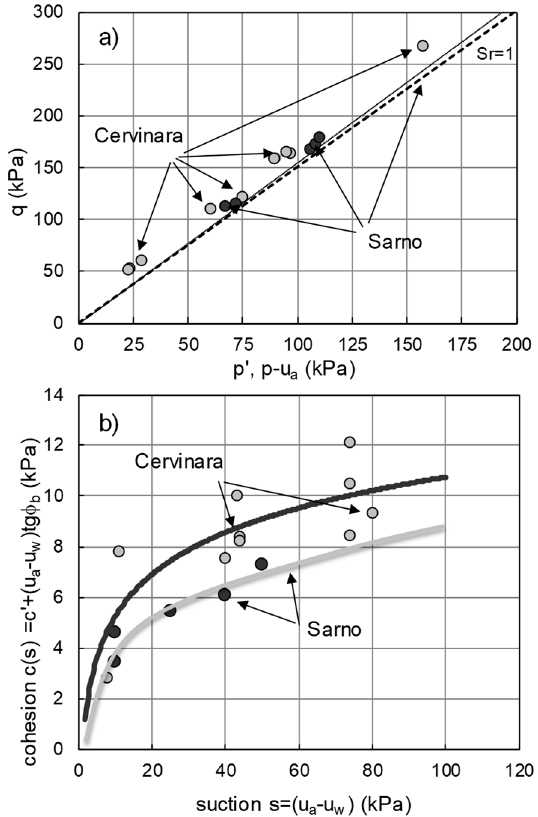
Figure 5. Shear strength: ( a ) stress plane; ( b ) intercept of cohesion as a function of suction.